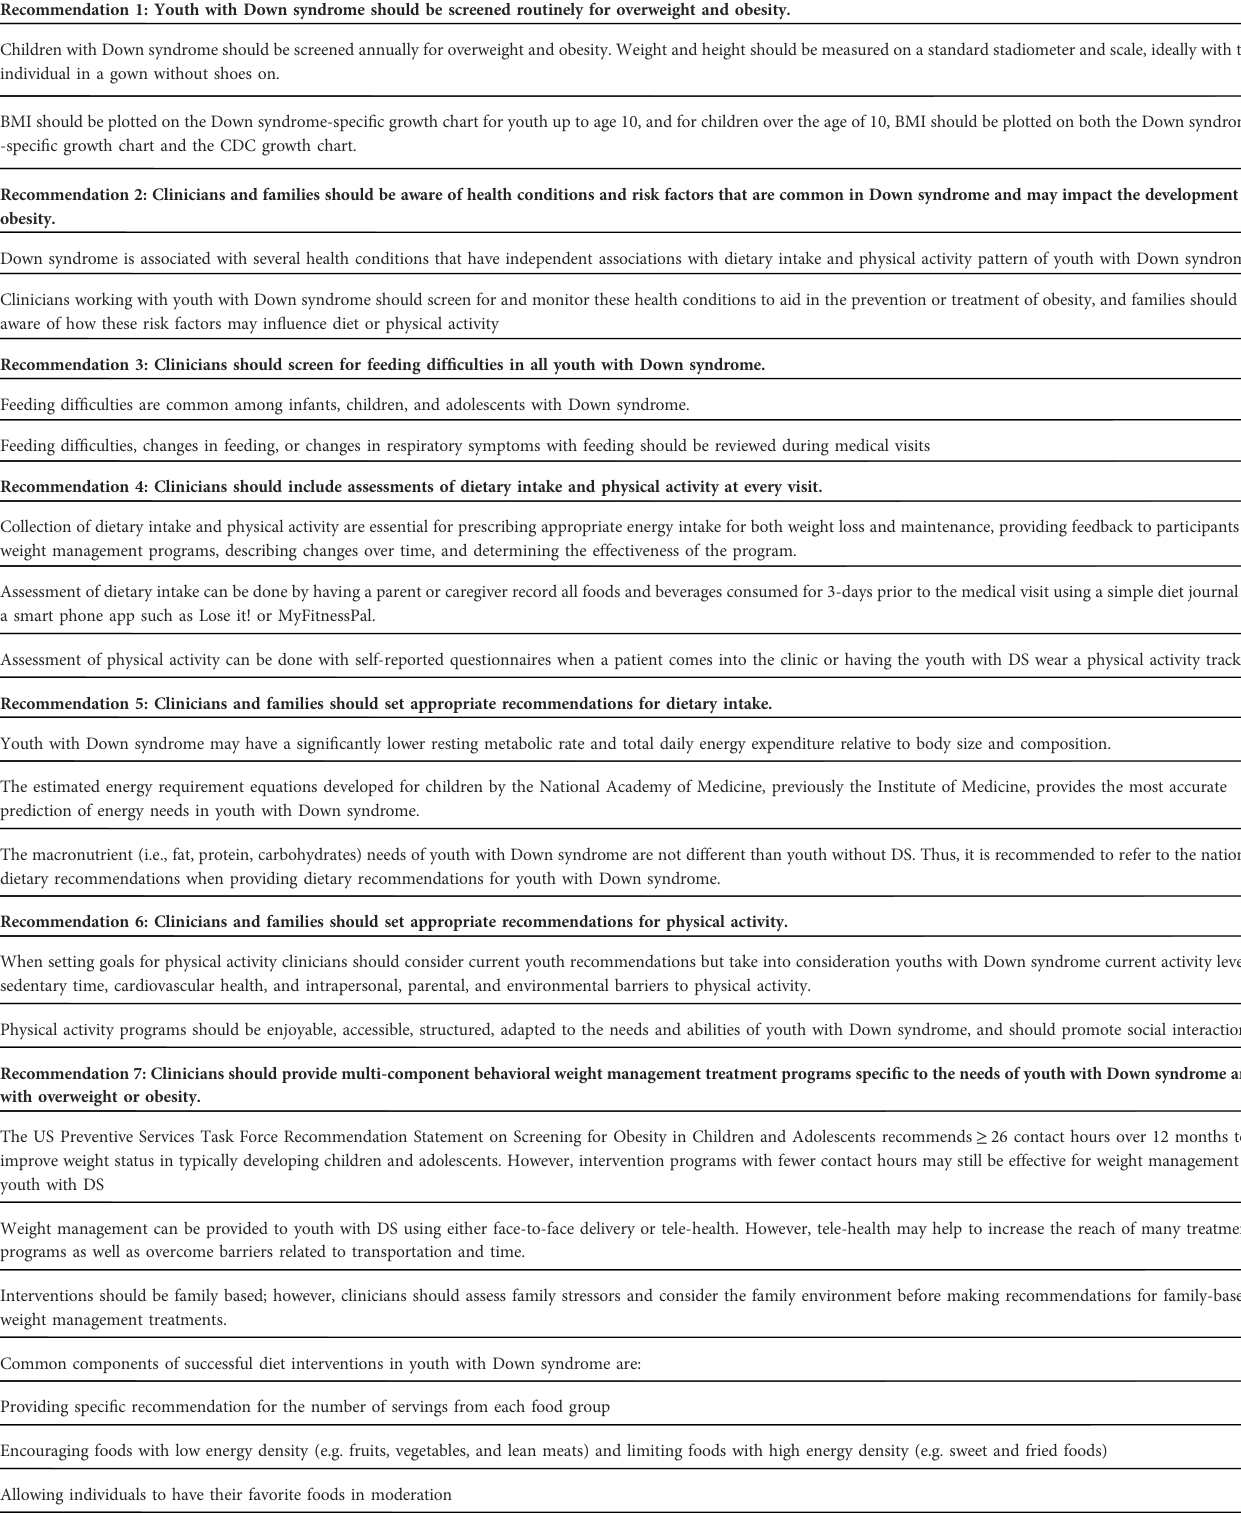
TABLE 6 Summary of weight management recommendations for youth with Down syndrome. Recommendation 1: Youth with Down syndrome should be screened routinely for overweight and obesity. Children with Down syndrome should be screened annually for overweight and obesity. Weight and height should be measured on a standard stadiometer and scale, ideally with the individual in a gown without shoes on. BMI should be plotted on the Down syndrome-speci fi c growth chart for youth up to age 10, and for children over the age of 10, BMI should be plotted on both the Down syndrome -speci fi c growth chart and the CDC growth chart. Recommendation 2: Clinicians and families should be aware of health conditions and risk factors that are common in Down syndrome and may impact the development of obesity.